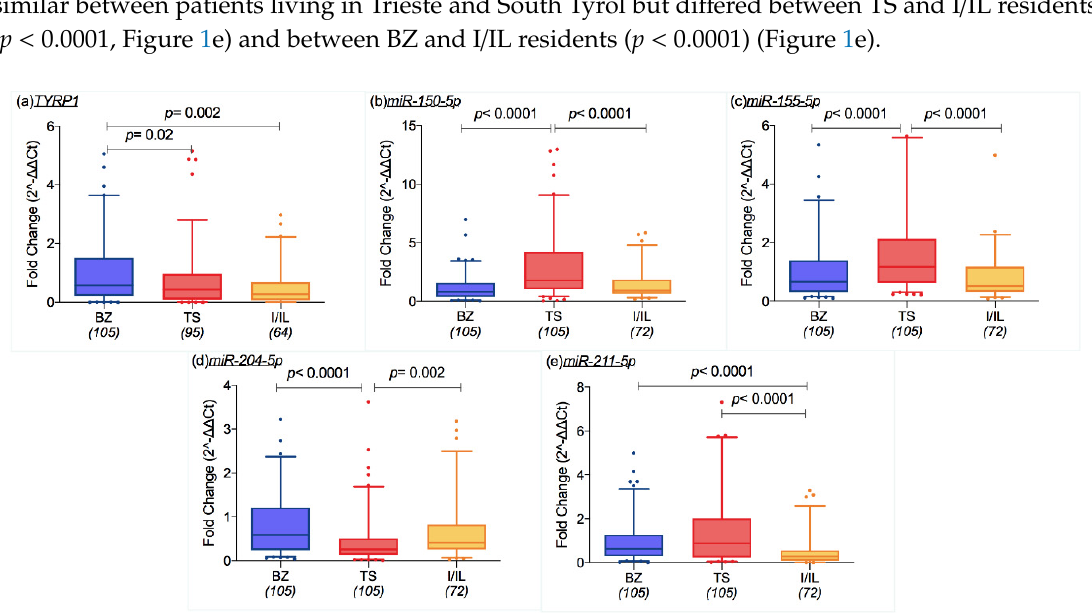
Figure 1. Box plots representing mRNA and miRNA expression levels (ratio of threshold cycles) that were different among the geographical areas: ( a ) Tyrosinase related protein 1 (TYRP1) was more expressed in the cohort of South Tyrol/Bozen (BZ), than in the province of Trieste TS and in the city of Innsbruck and Innsbruck-Land district (I / IL) ( p = 0.02 and p = 0.002); ( b ) miR-150-5p and ( c ) miR-155-5p were more expressed in TS samples than BZ and I / IL ones (each comparison showed p < 0.0001); ( d ) miR-204-5p expression is lower in TS patients in comparison to those who live in BZ and I / IL ( p < 0.0001, p = 0.002, in order); ( e ) miR-211-5p expression was lower in I / IL than the TS and BZ groups (both p < 0.0001). The box extends from the 25th to the 75th percentiles, the middle line indicates the median and the whiskers are the 5th and 95th percentiles (Mann–Whitney